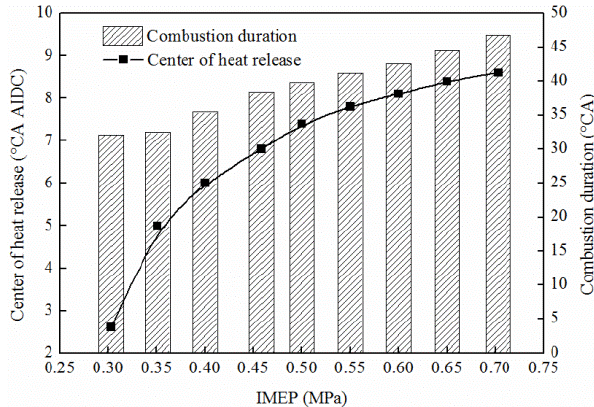
Figure 10. COHR and CD at different